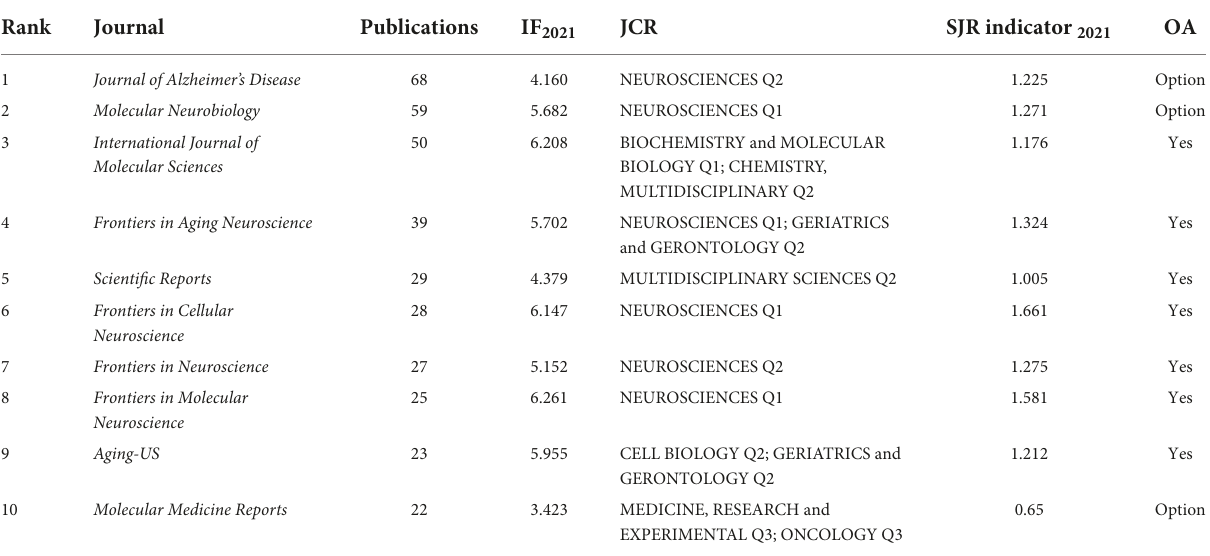
TABLE 2 Top 10 journals with the most